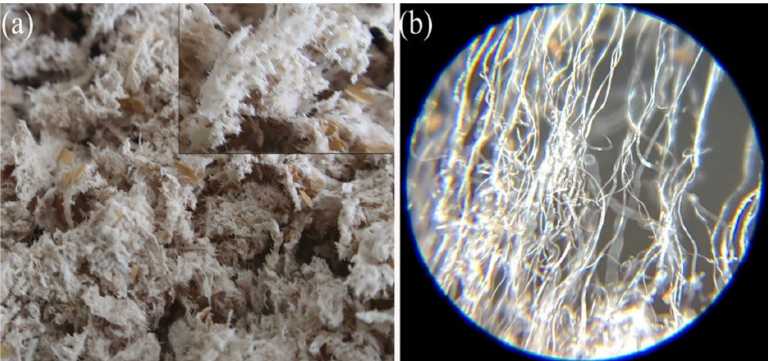
Figure 5. ( a ) Photograph of crude gutta-percha obtained after ultrasonic treatment and ( b ) optical micrograph of gutta-percha ( ×